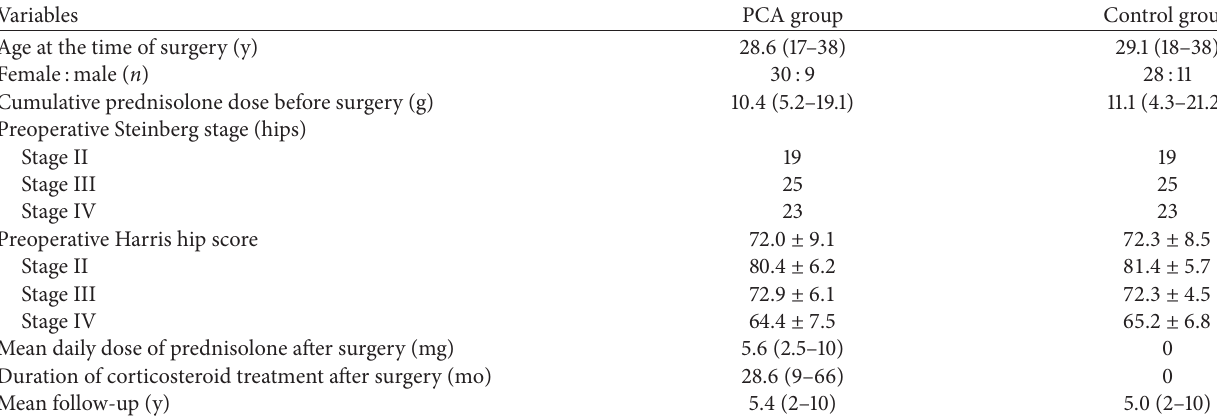
Table 1: Demographic details of patients.